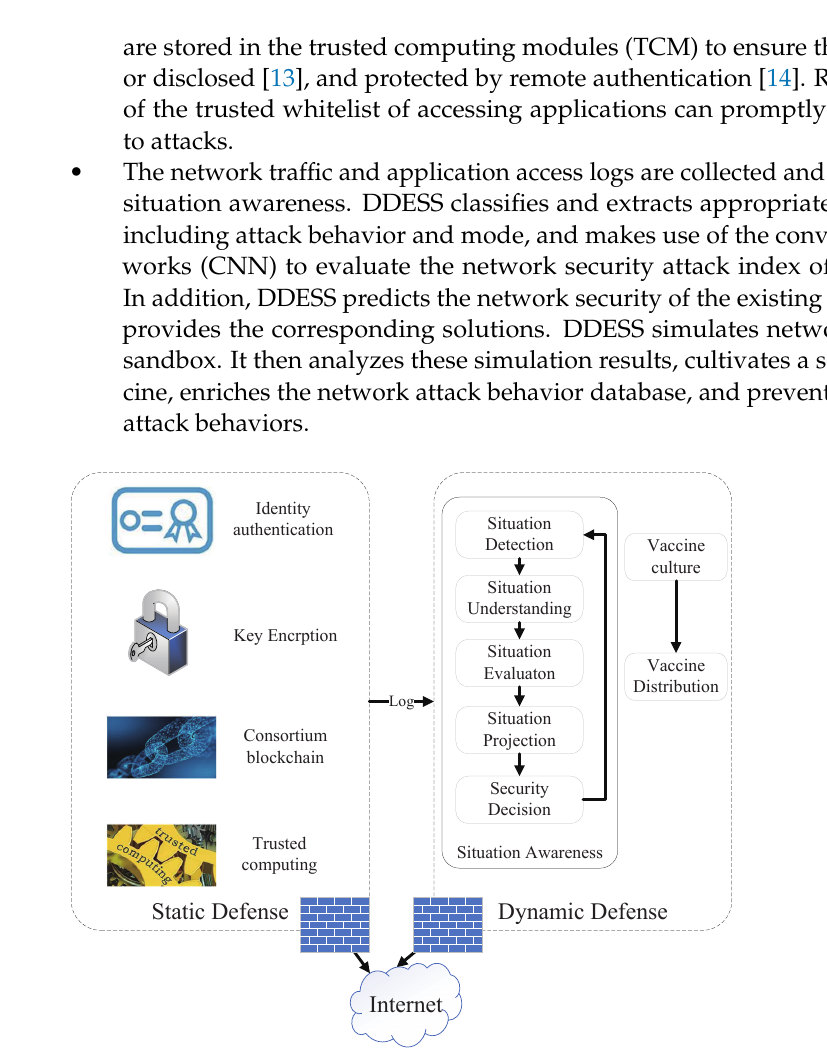
Figure 2. Double defense strategy with endogenous safety and security